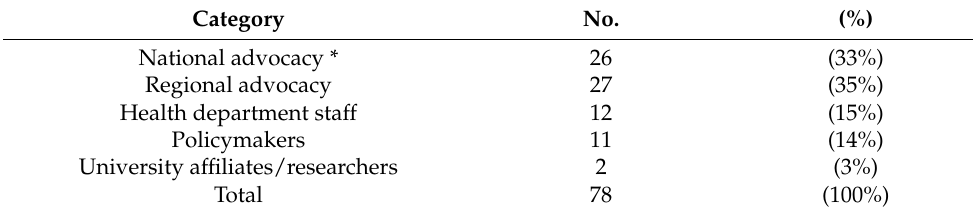
Table 1. Affiliation of Tobacco 21 case study participants from 10 states (N = 78), November 2018 –